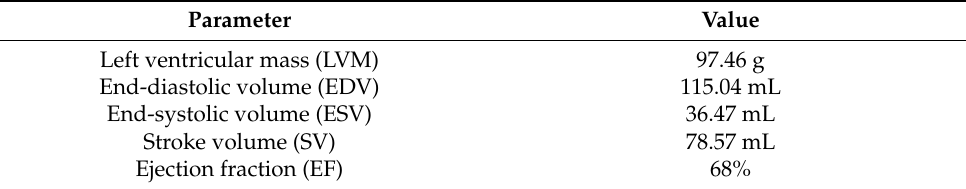
Ejection fraction (EF)